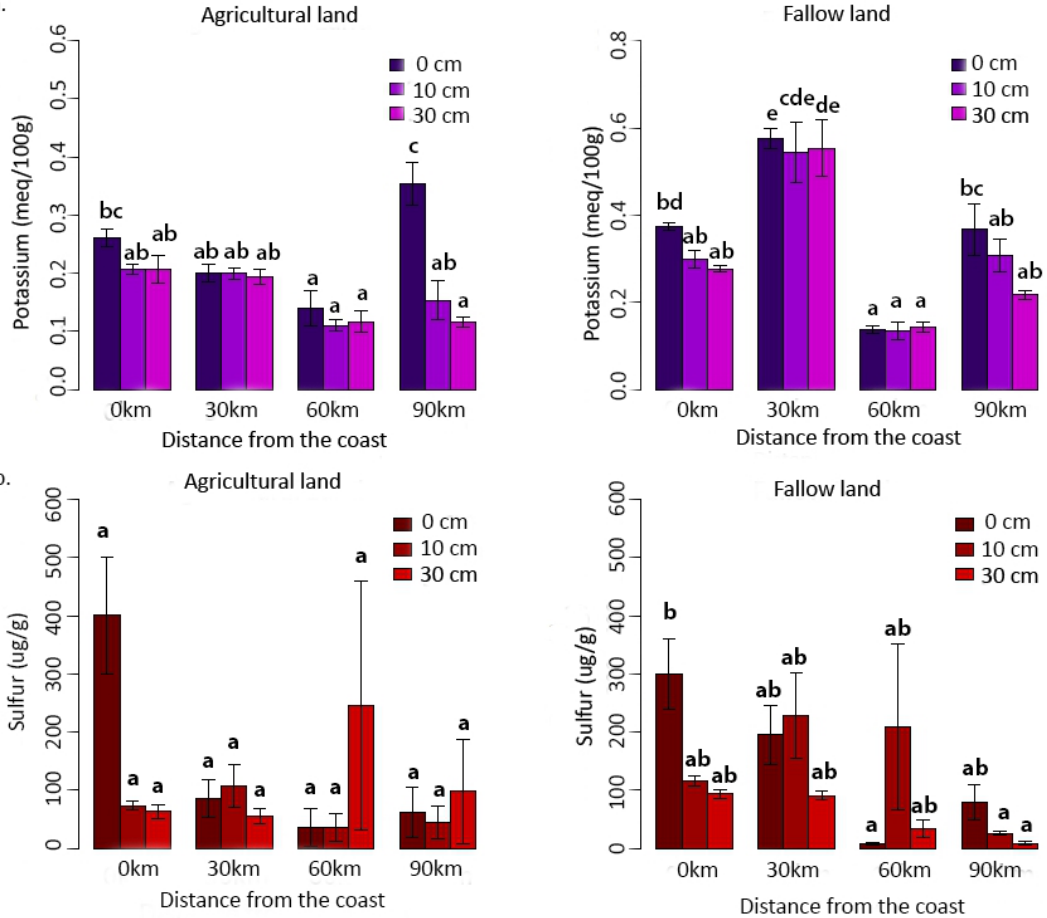
Fig. 6: Bar graphs showing the soil K (6a) and S (6b) differences between agricultural and fallow land along a distance gradient from coastline in different soil depths. Different letters above the error bars denote significant differences among the groups based on Tukey’s post-hoc test at α≤0.05 where homogeneous letter subsets are expressing non-significant difference variances among the groups were homogeneous according to Bartlett’s test (K-squared=11.98 11, p=0.36). Significant differences have been marked in